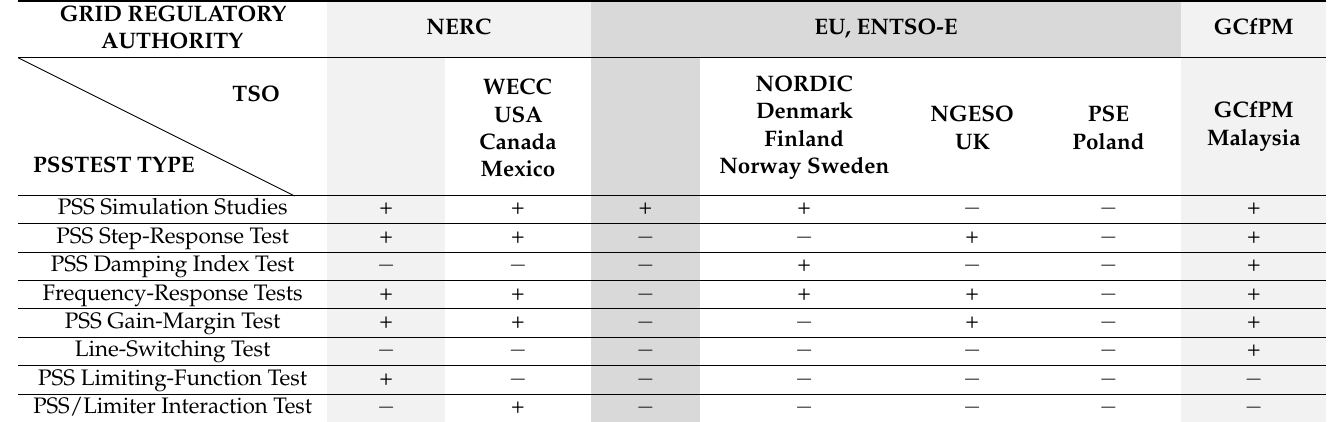
Table 2. Summary of the PSS tests required ( + ) by grid regulatory authorities and their